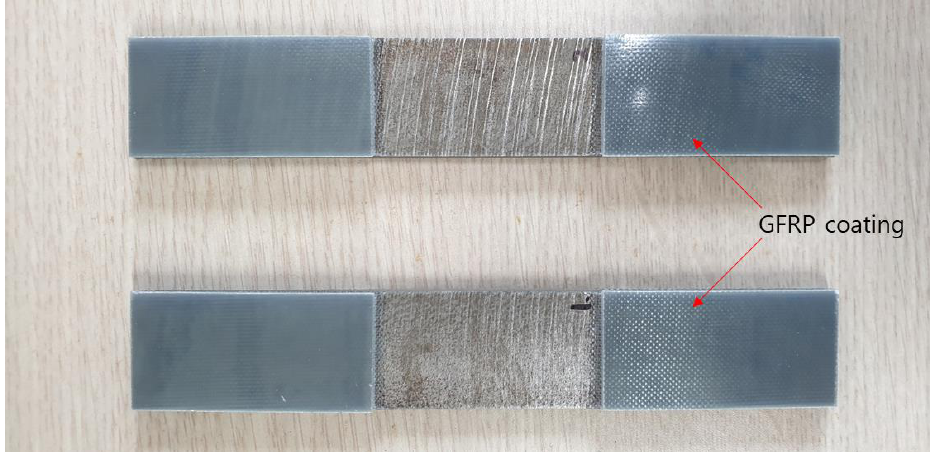
Figure 2. Photograph of specimens for experiment to measure stress under tensile loads.